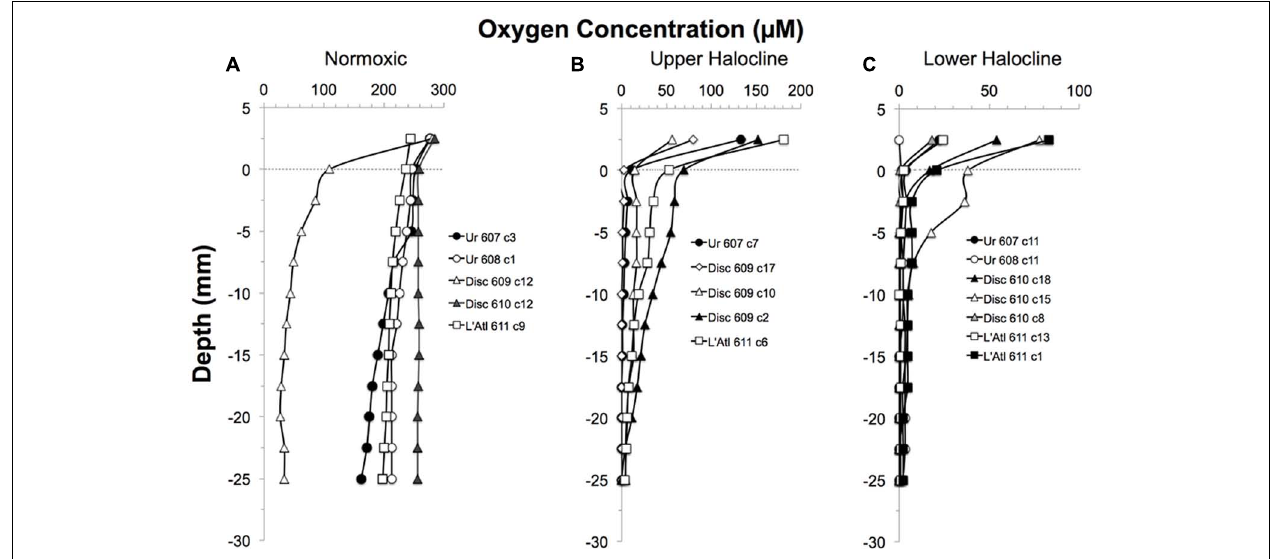
FIGURE 3 | Depth profiles of the oxygen concentrations in overlying waters and sediments of pushcores collected for this study, presented by DHAB and general habitat. From left to right: Normoxic (control; A ); Upper Halocline (B) ; Lower Halocline (C) .